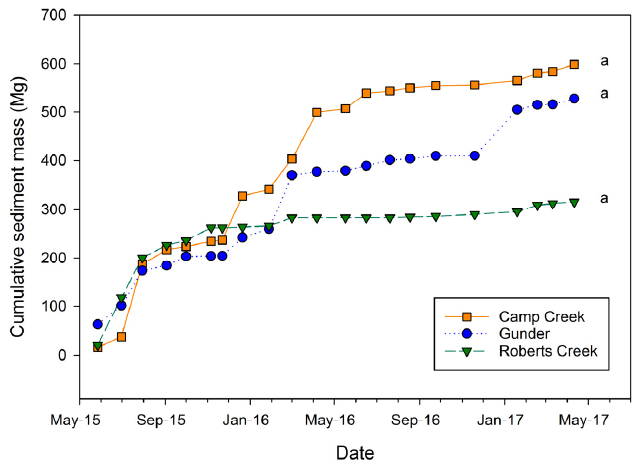
Figure 9. Cumulative mean sediment mass loss for Camp Creek, Roberts Creek, and Gunder alluvial units, for the main stem of Walnut Creek, Iowa. Significant differences ( p value < 0.1) indicated by differing lower-case letters. Error bars omitted for clarity.